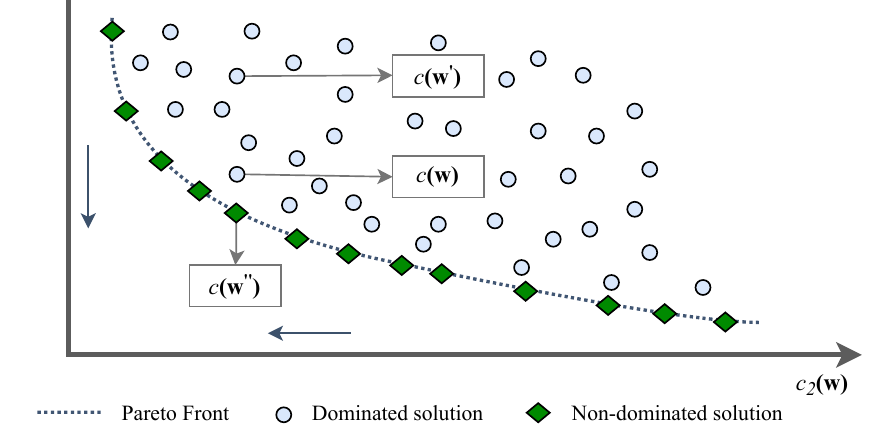
Figure 2. Bi-dimensional objective space with a Pareto front using standard nomenclature on the